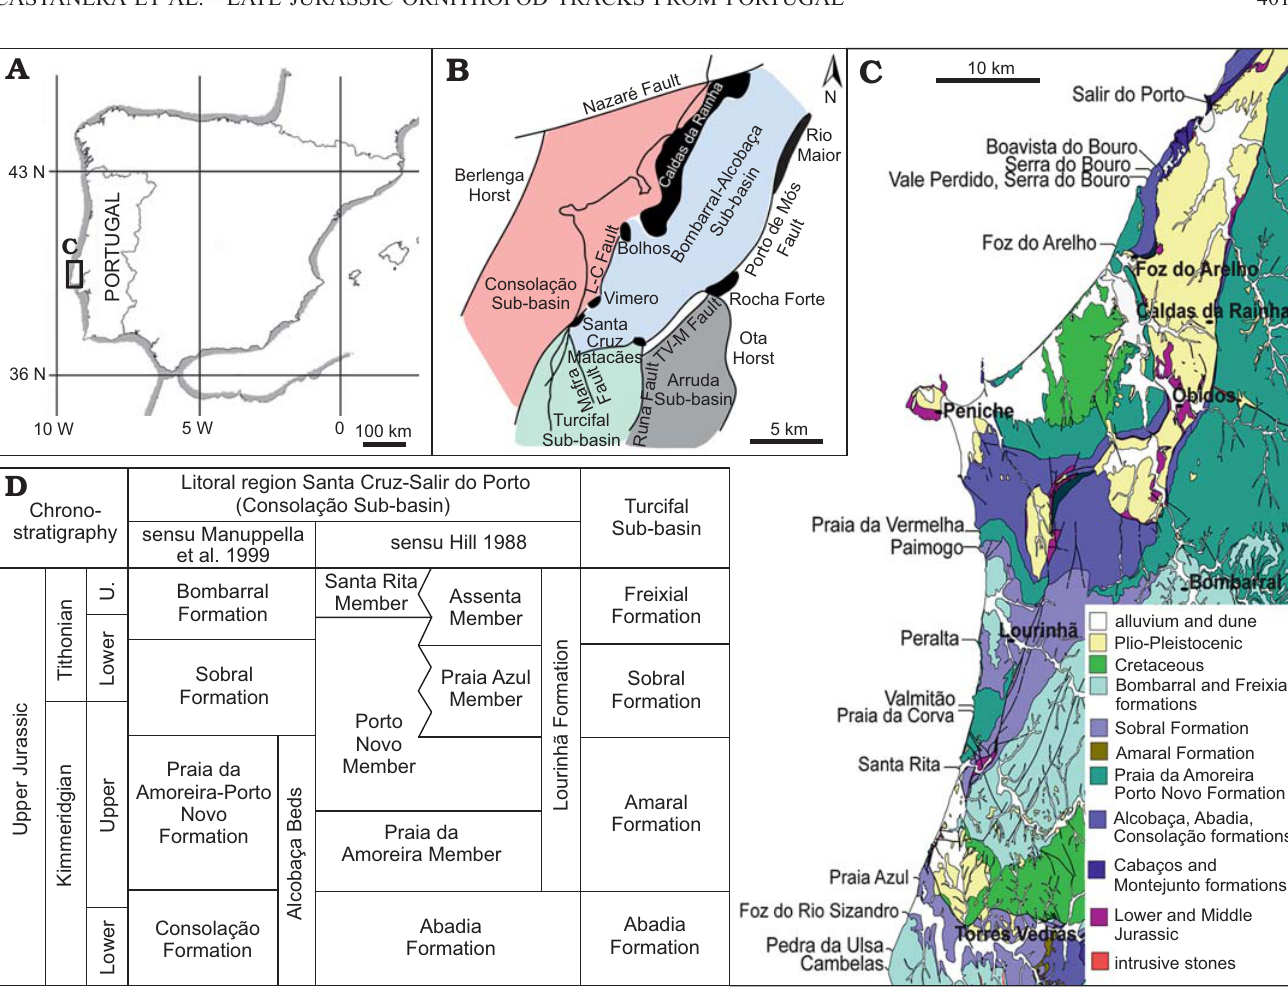
Fig. 1. Geographical and geological setting of the outcrops where the studied footprints were collected. A . Map of the Iberian Peninsula showing the location of the Lusitanian Basin. B . Structural setting of the Late Jurassic sub-basins in the western and central sector of the Lusitanian Basin (modified after Taylor et al . 2014). C . Geological map of the western and central sector of the Lusitanian Basin showing the localities where the described specimens were col- lected (adapted from Oertel et al. 1960; Oliveira et al . 1992). D . Stratigraphic correlation of Upper Jurassic units of the Consolação and Turcifal